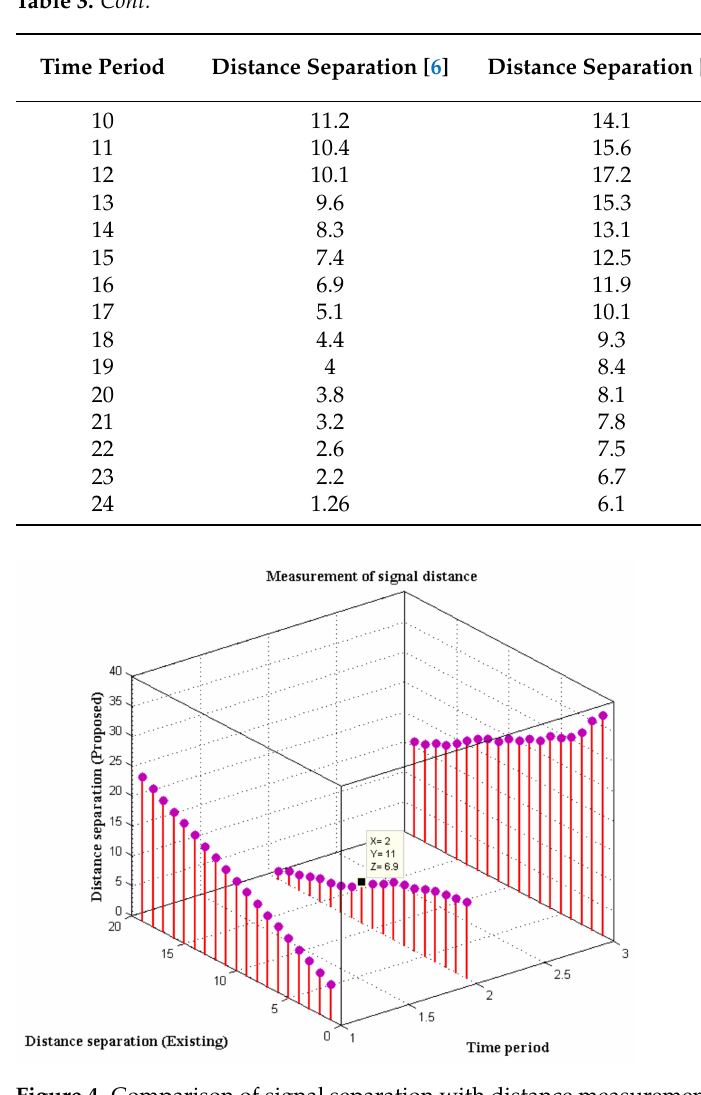
Figure 4. Comparison of signal separation with distance